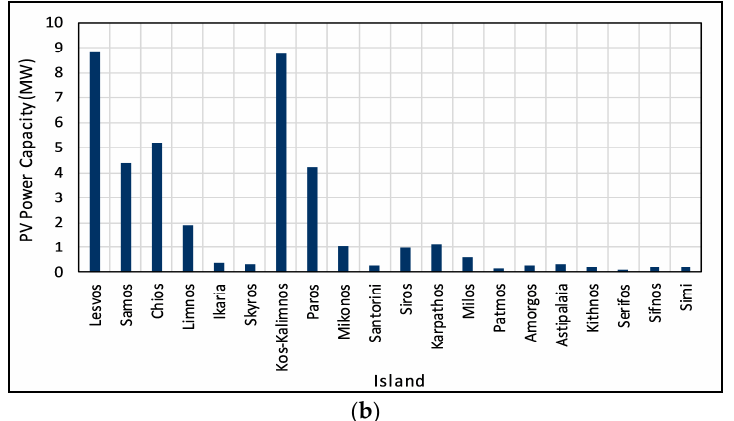
Figure 3. ( a ) Installed wind power capacity; ( b ) PV power capacity in NIIs of the Aegean Archipel- agos.